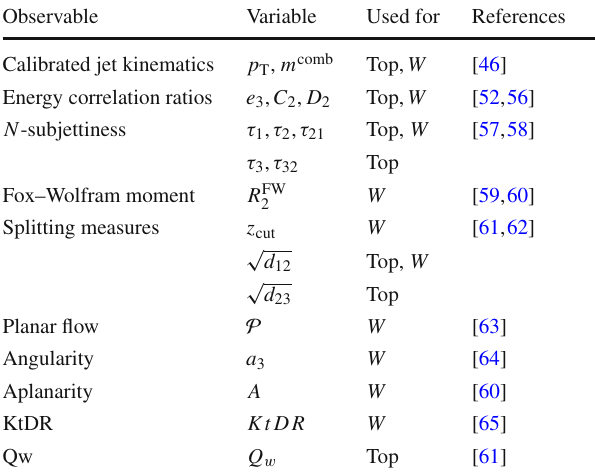
Table 1 Summary of jet moments studied along with an indication of the tagger topology to which the observable is applicable. In the case of the energy correlation observables, the angular exponent β is set to 1.0 and for the N -subjettiness observables, the winner-take-all [55] configuration is used. A concise description of each jet moment can be found in Ref.